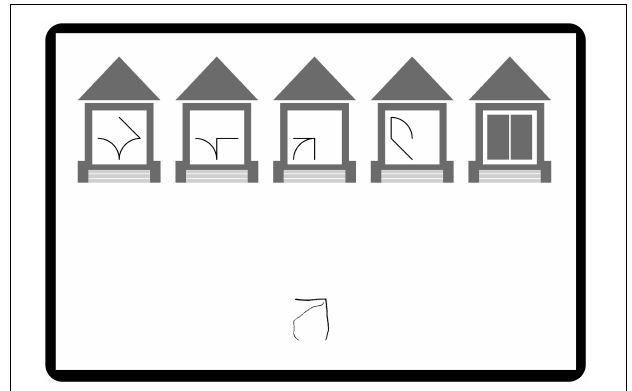
FIGURE 5 | Categorization task: example of